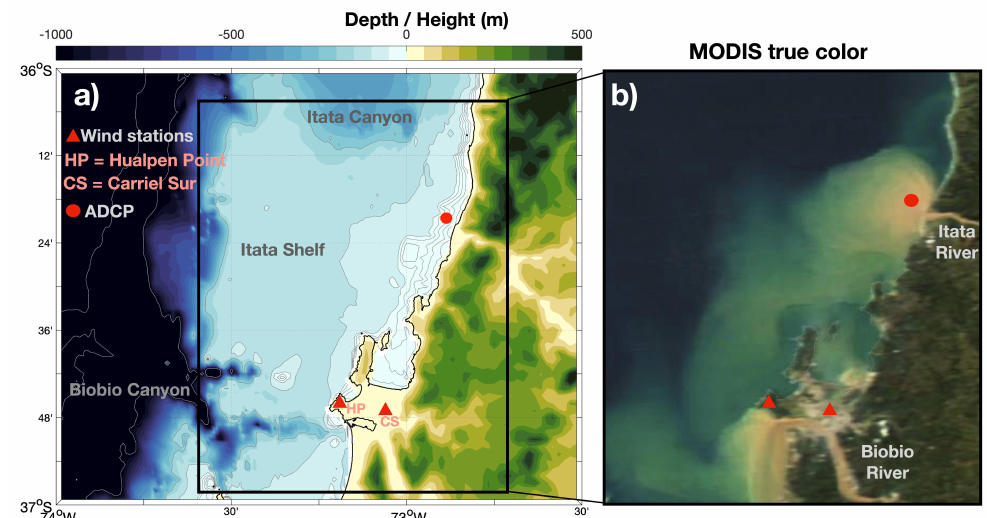
Figure 1. ( a ) Study area off central Chile showing the bathymetry/height in colors. The locations of the ADCP and wind stations in Hualpen Point (HP) and Carriel Sur (CS) are shown in a red circle and red triangles, respectively. A MODIS true color image (on 20 June 2009) of the enclosed area (black box) is presented in ( b